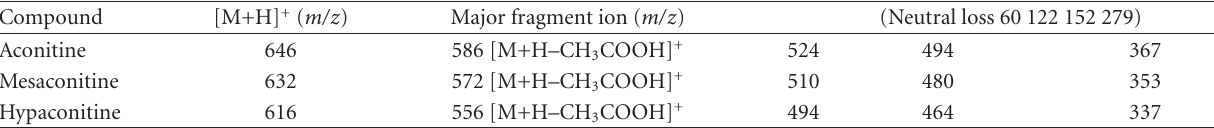
Table 5: Protonated molecular ions and characteristic fragment ions of aconitum alkaloids obtained by ESI/MS/MS. Compound [M+H] + ( m/z ) Major fragment ion ( m/z ) (Neutral loss 60 122 152